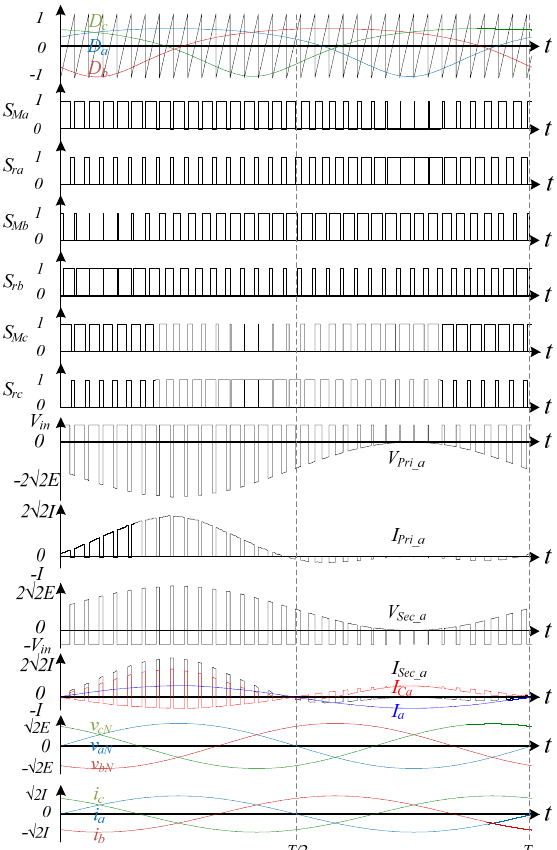
Figure 3. Proposed IFBI PWM control strategy.